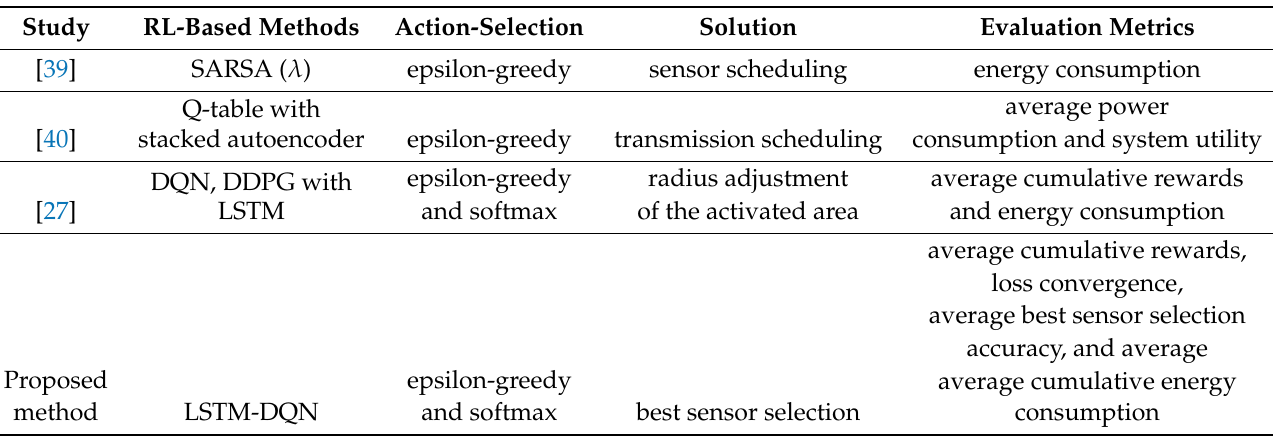
Table 1. Related work that use RL-based methods to reduce the energy consumption of the sensor.